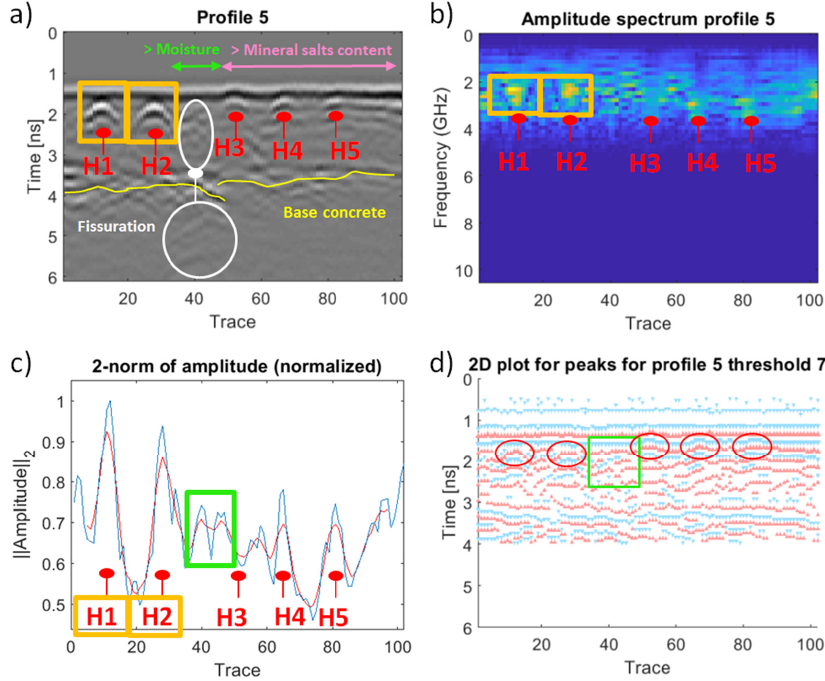
Figure 9. Graphics obtained for GPR profile 5 and interpretation. The pink arrow in ( a ) represents a zone with high salt concentration, while the lawn green arrow indicates higher moisture. The orange rectangles in ( a – c ) indicate open-air rebars. The red circles in ( d ) represent a positive polarity of the reflections produced by the rebars, while the lawn green rectangle represents negative polarity due to moisture. Remote Sens. 2017 , 9 , x FOR PEER REVIEW 15 of 24